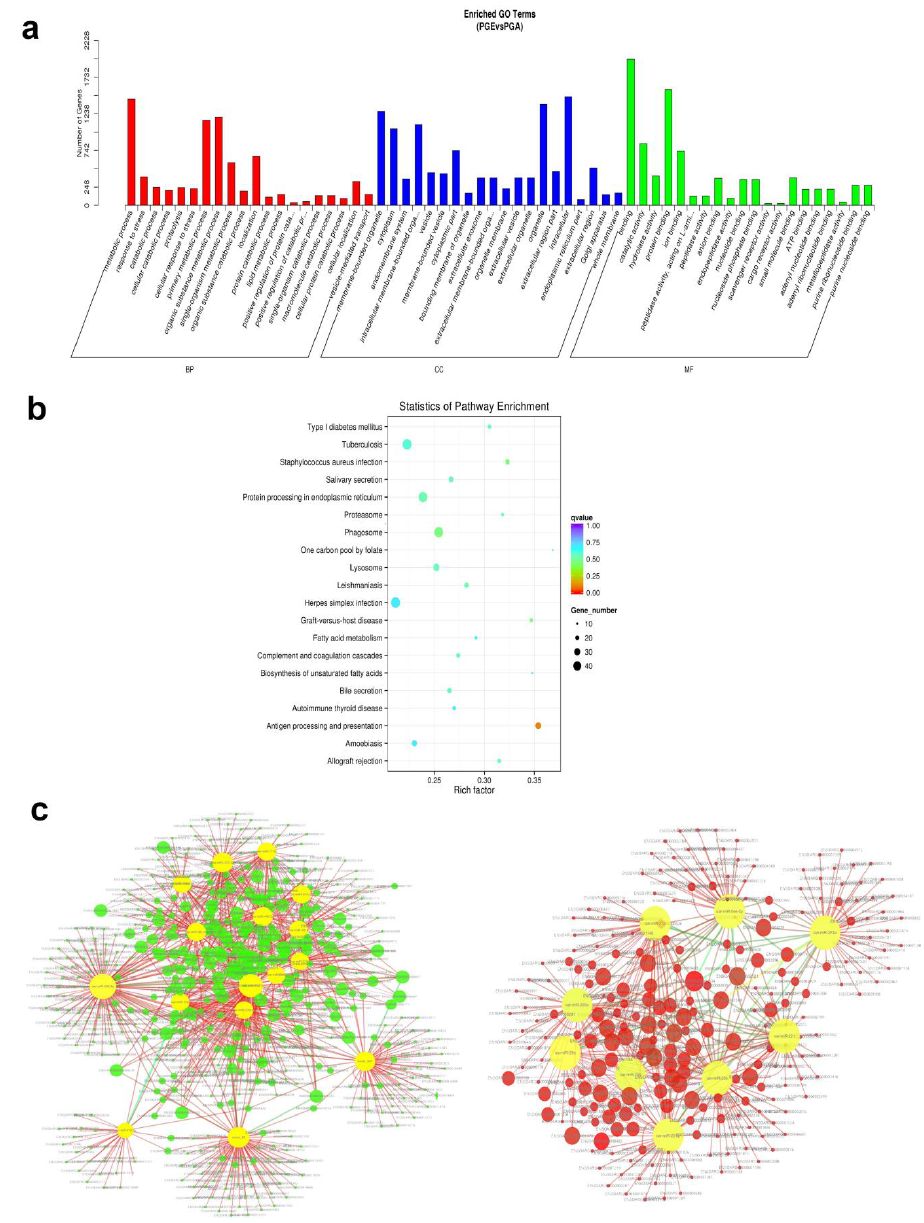
Figure 7. Enrichment analysis and annotation of miRNAs. ( a ) Gene ontology (GO) enrichment analysis of miRNAs differentially expressed in PGA and PGE ( p < 0.05). Horizontal axis is the next level of GO polymer and GO terminology. Vertical axis is the ratio of genes annotated to the term. ( b ) miRNA differentially expressed host genes were subjected to Kyoto Encyclopedia of Genes and Genomes (KEGG) enrichment analysis ( p < 0.05). The vertical axis signifies an access name and the horizontal axis signifies the access coefficient. Dots show the quantity of genes enriched during the visit. Colors are parallel to different q-values. ( c ) Regulatory networks of miRNA – mRNA. The left and right sides represent network regulation of up miRNA-down mRNA and down miRNA-up